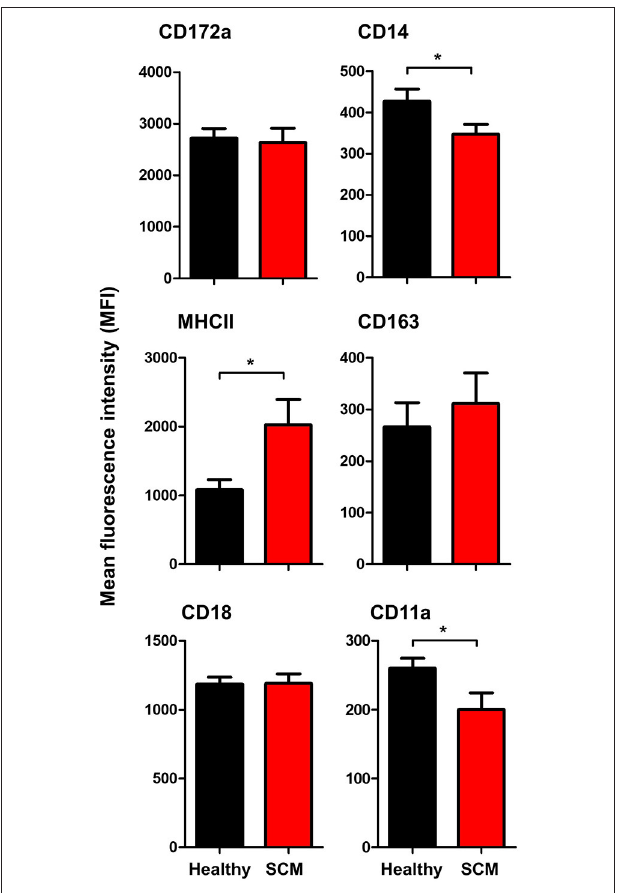
FIGURE 7 | Impact of SCM on the phenotype of milk macrophages. Separated milk cells were stained with monoclonal antibodies to CD172a, CD14, CD163, MHCII, CD18, and CD11a and stained cells were analyzed by flow cytometry. After setting a gate on milk macrophages (based on their higher expression of CD14), the mean fluorescence intensity of the monocytic cell markers and the cell adhesion molecules was calculated and presented for healthy and SCM animals. *indicates significant differences between the means with p -values < 0.05.